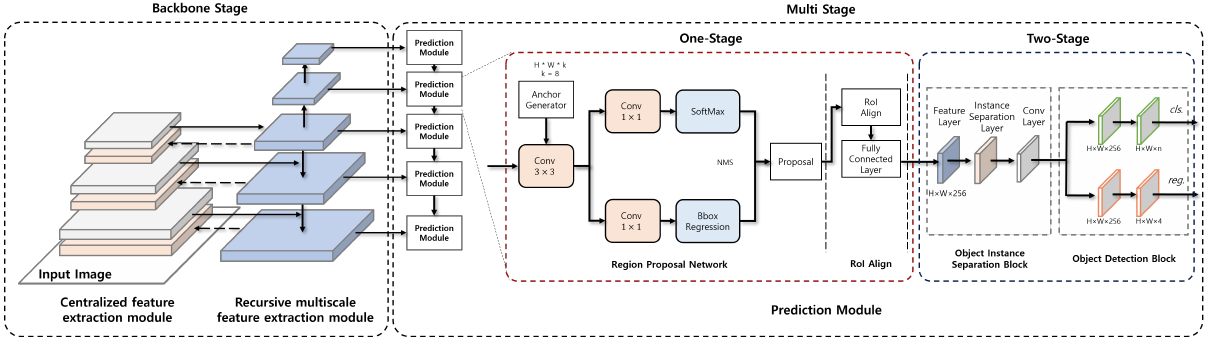
Figure 5. ARTD-Net2.